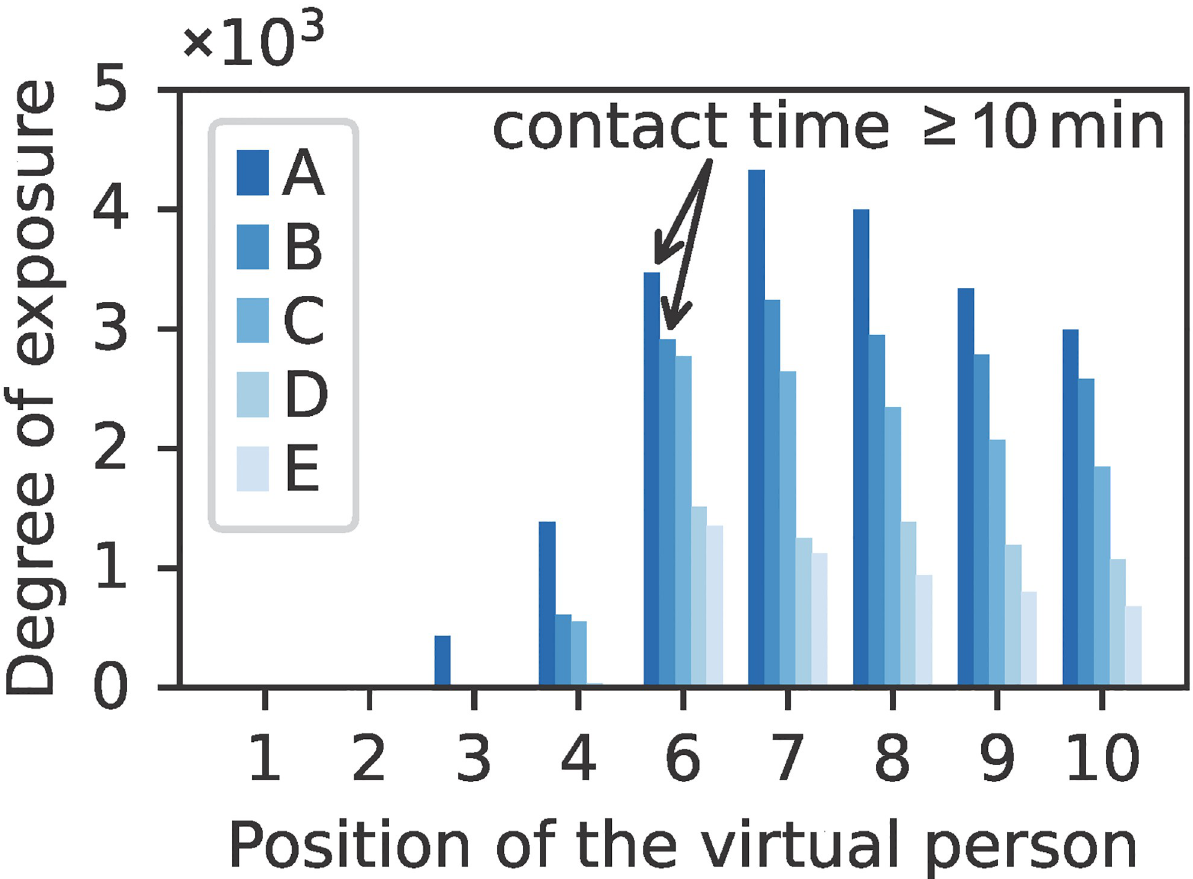
Fig 12. Individual degree of exposure for the queue scenarios. The variation of the potential parameter p and corridor distance d c leads to a different exposure of the susceptible persons (1–4, 6–10). For scenario A and B, the contact time between the person at the sixth position and the infectious person, that is the period during which their mutual distance is less than 1.5 m, is greater than 10